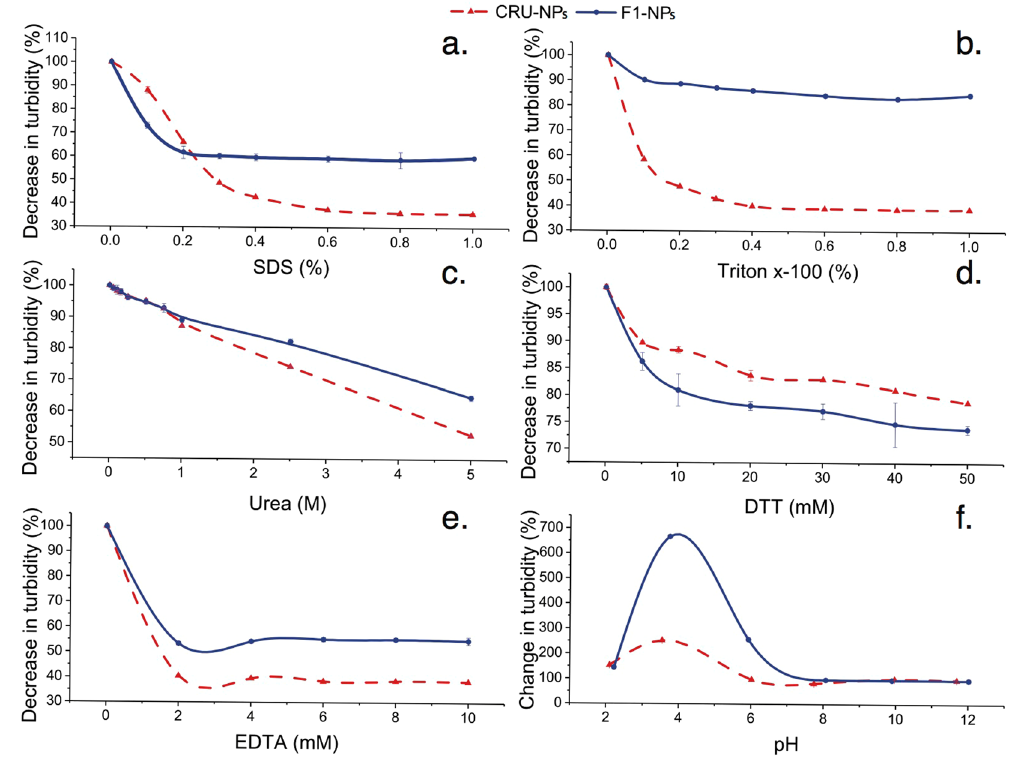
Figure 4. Decrease in turbidity of F1-NPs (nanoparticles formed from cruciferin peptide fraction < 10 kDa) and CRU-NPs (nanoparticles formed from cruciferin peptides) in the presence of ( a ) SDS, ( b ) Triton x-100, ( c ) urea, ( d )1,4-dithiothreitol (DTT), ( e ) ethylenediaminetetraacetic acid (EDTA) and changes in turbidity at ( f ) various pH